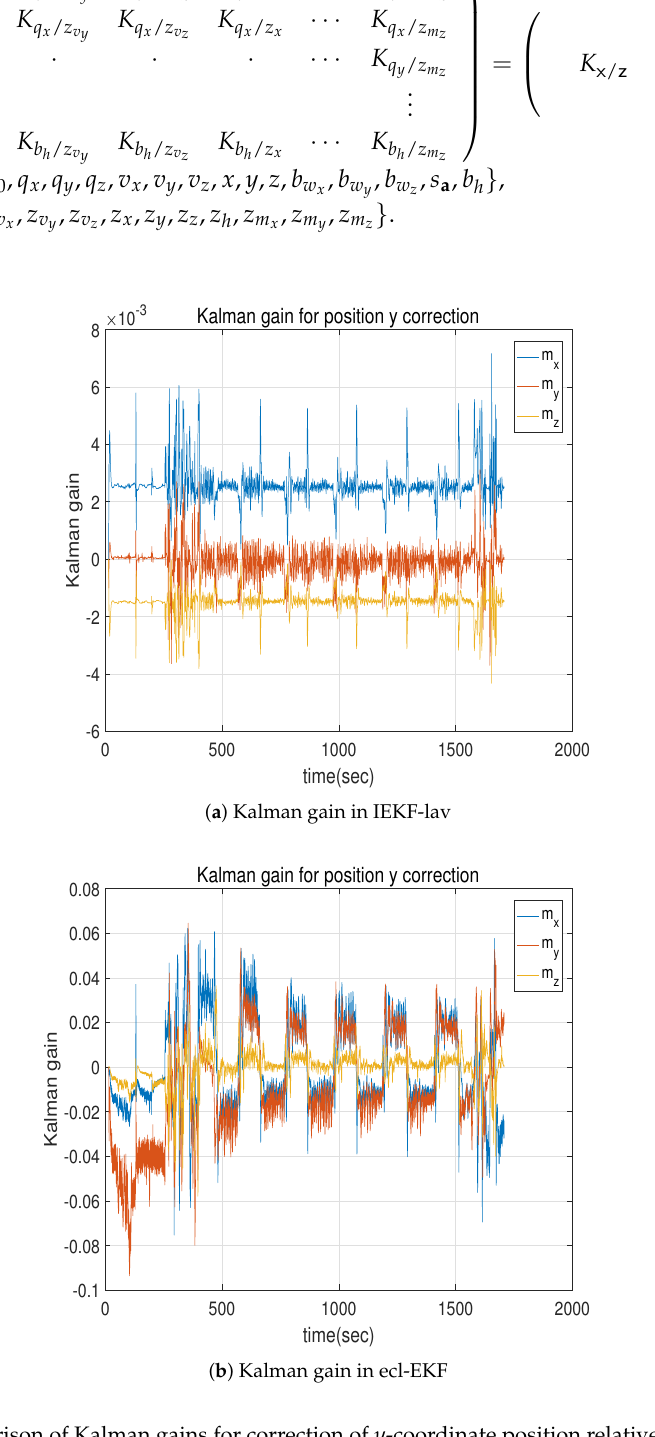
Figure 7. Comparison of Kalman gains for correction of y -coordinate position relative to magnetic field measurement